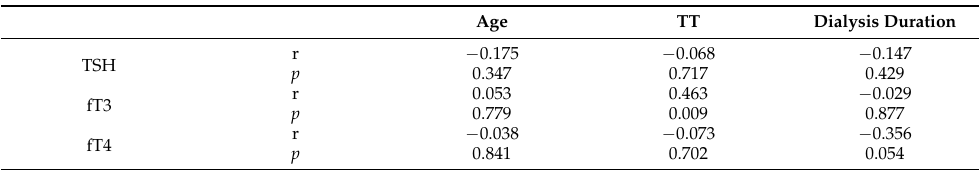
Table 2. Correlations between the thyroid hormone concentrations and age, total testosterone concentrations, and dialysis duration in the HD